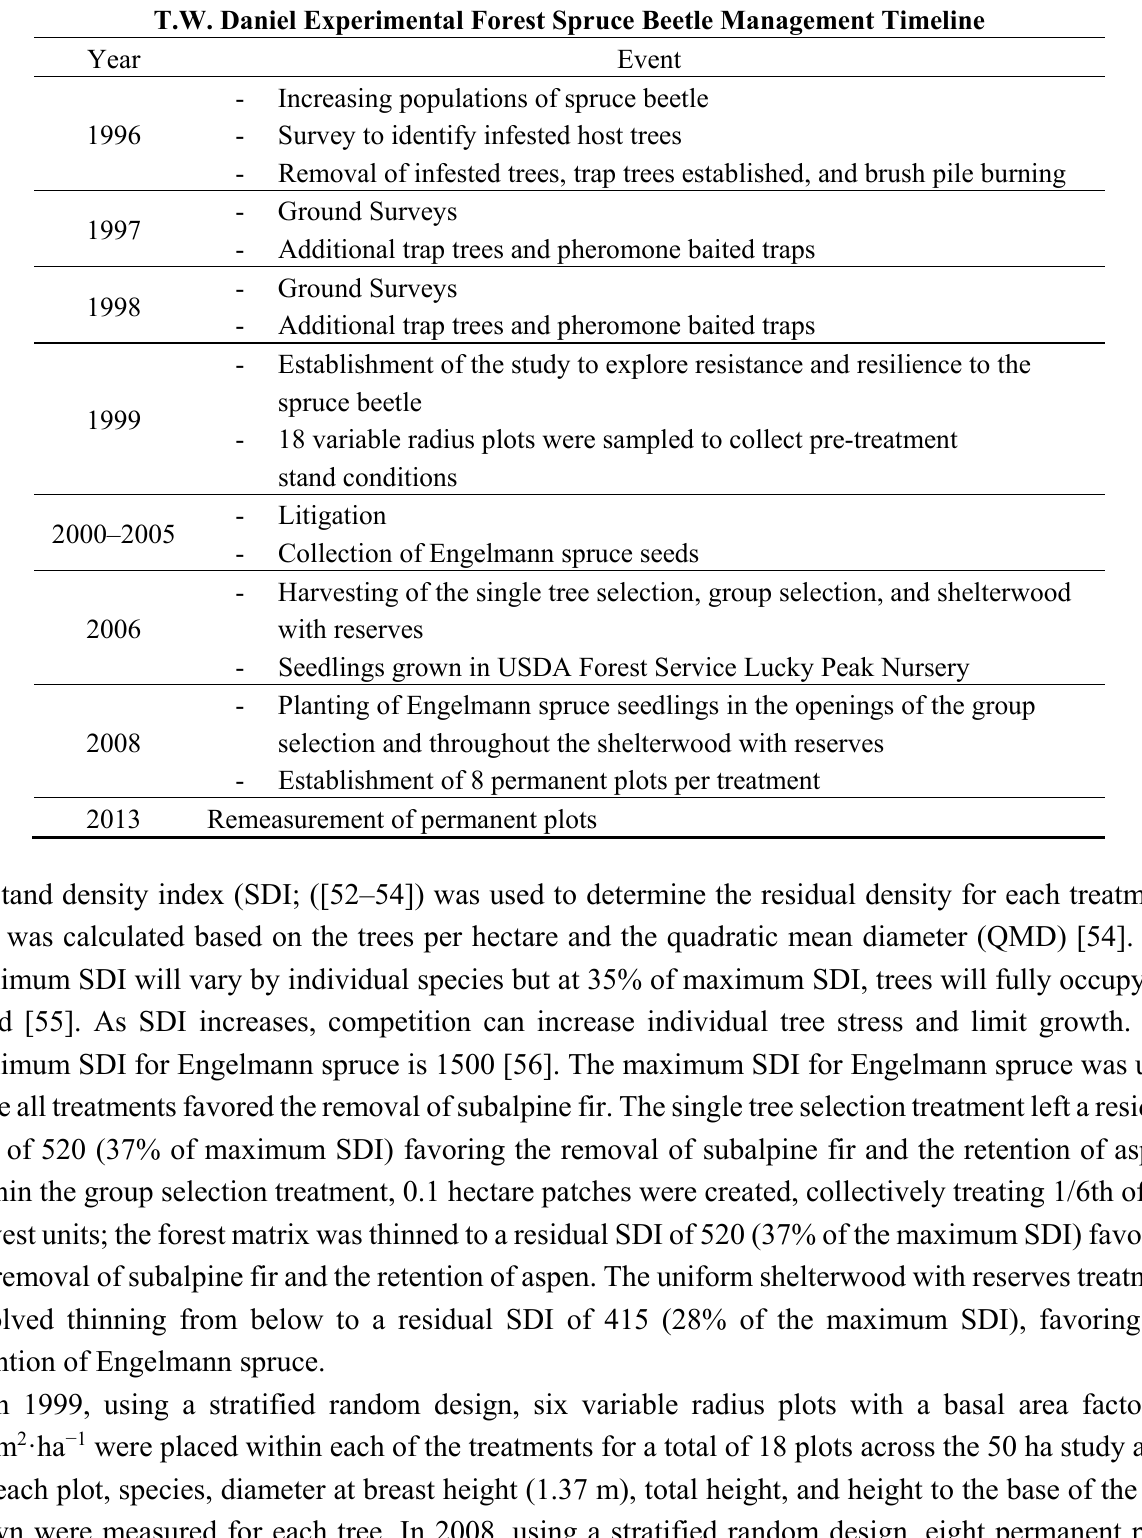
Table 1. T . W. Daniel Experimental Forest in northern Utah spruce beetle management timeline. Additional information on suppression efforts and results can be found in